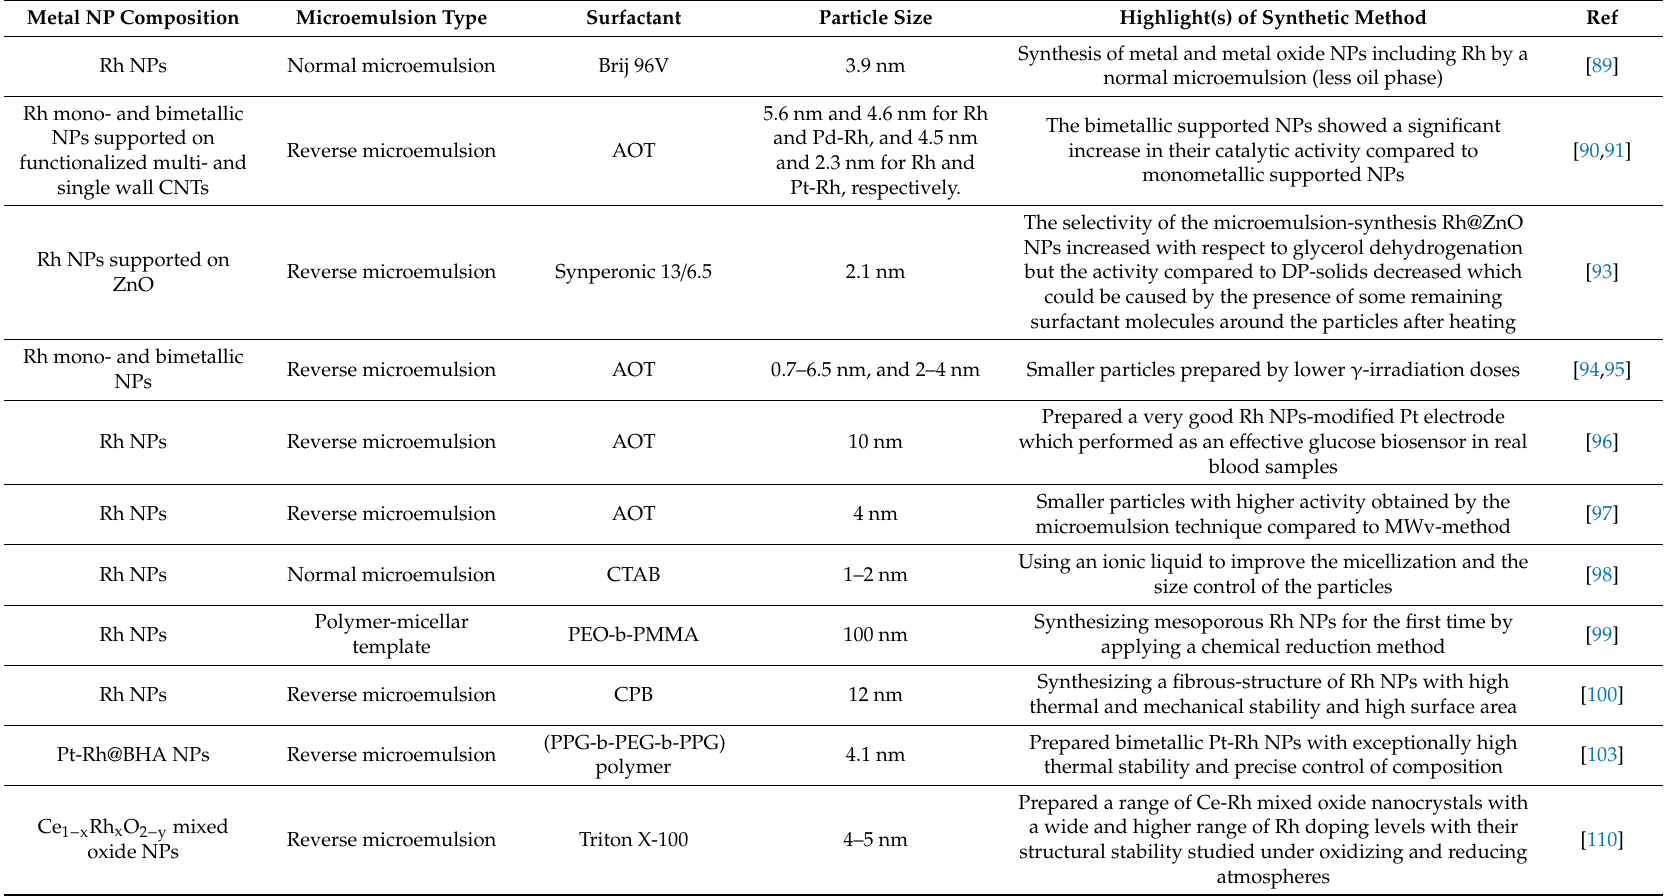
Table 3. Recent development in microemulsion-based synthesis of Rh NPs. CPB—cetylpyridinium